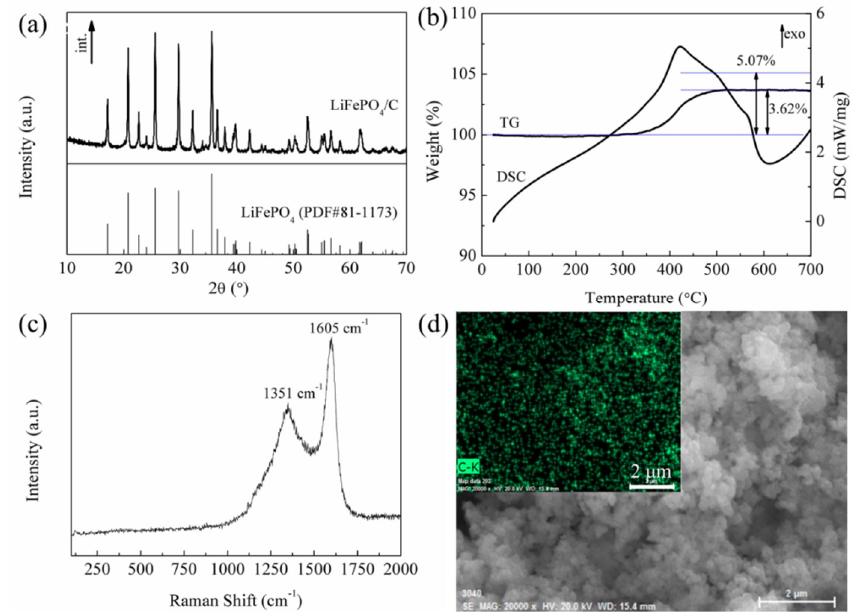
Figure 2. ( a ) XRD pattern of LiFePO 4 /C composite; ( b ) TG-DSC curves of the LiFePO 4 /C composite recorded from the room temperature to 700 °C at a heating rate of 10 °C min −1 in air; ( c ) Raman spectrum of LiFePO 4 /C composite; and ( d ) EDS mapping of C in the LiFePO 4 /C composite.